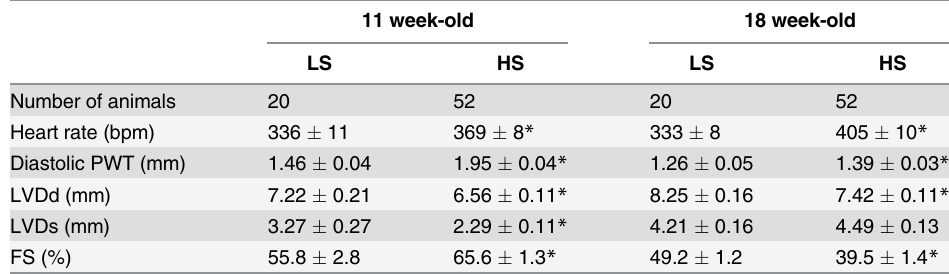
Table 2. Body weight, pulse rate and blood pressure of 11 week-old DS rats. 11 weeks old LS HS Number of animals 20 52 Body weight (g) 367 (cid:1) 4 359 (cid:1) 2 Pulse rate (bpm) 373 (cid:1) 7 413 (cid:1) 4 * Systolic blood pressure (mmHg) 125 (cid:1) 3 187 (cid:1) 2 * Diastolic blood pressure (mmHg) 93 (cid:1) 3 139 (cid:1) 2 * Values are expressed as the mean (cid:1) SEM. * P < 0.05 versus LS. DS rats , Dahl salt-sensitive rats; LS , rats fed a low-salt diet; HS , rats fed a high-salt diet; SEM, standard error of the mean.